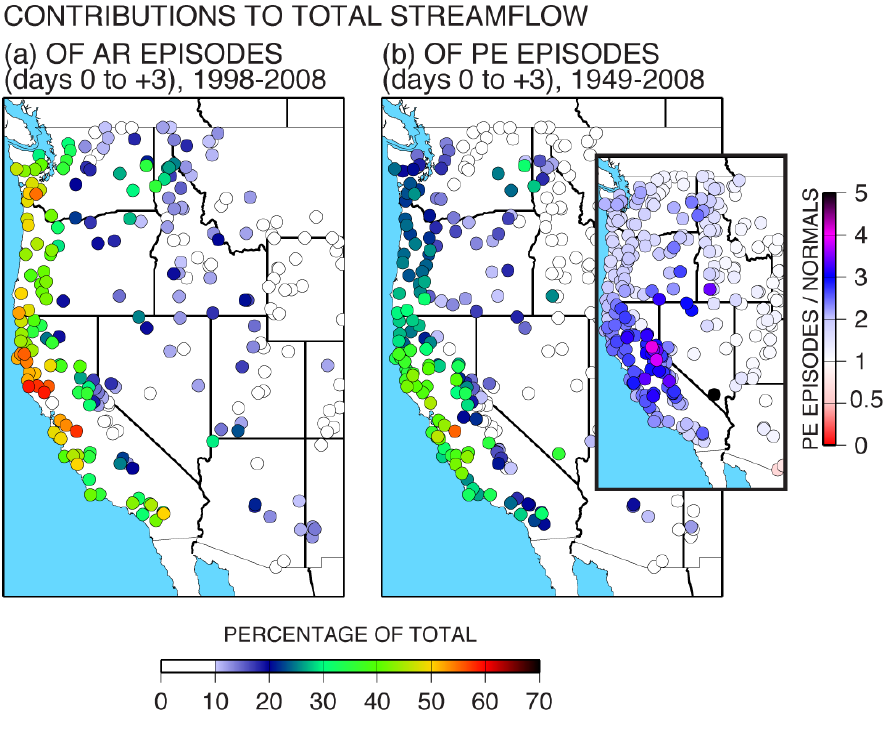
Figure 9. Contributions of streamflow during wet-season (November-April) episodes when atmospheric rivers (as ARs and PEs) made landfall on the West Coast to overall streamflow at HCDN streamflow gauging stations [14] in the western US, for (a) AR episodes, water years 1998–2008, based on Table 1, and (b) PE episodes, water years 1949–2008, based on Table 2 (including streamflow in each case from PE-concurrent day and three following days). Inset map shows the ratio of average streamflow on the PE days (including concurrent day and 3 following days) to climatological means for the same combination of days. Concurrent and three following days are considered to allow for streamflow response times from the basins. Nonetheless, because higher-altitude mountains, such as the Sierra, capture large amounts of snow during AR or PE events that does not runoff until spring or summer, runoff percentages from these regions are expected to be underestimates